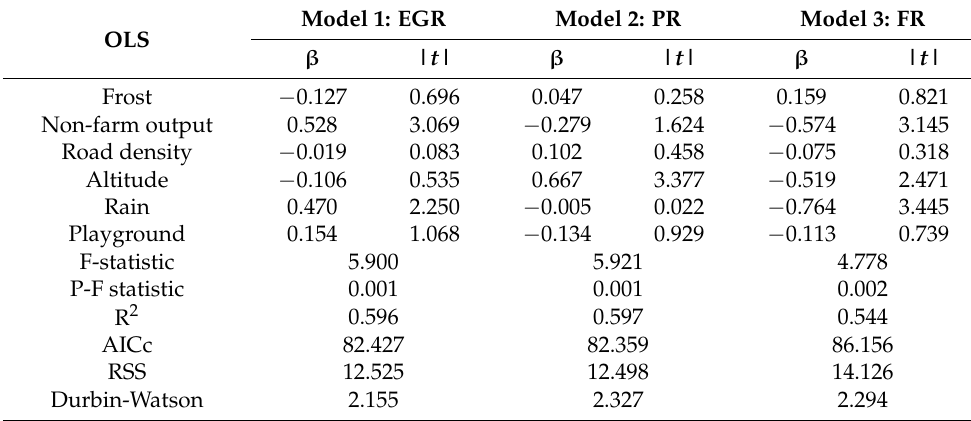
Table 4. Overall results of the three types of regression models (MGWR). Model 1: MGWR